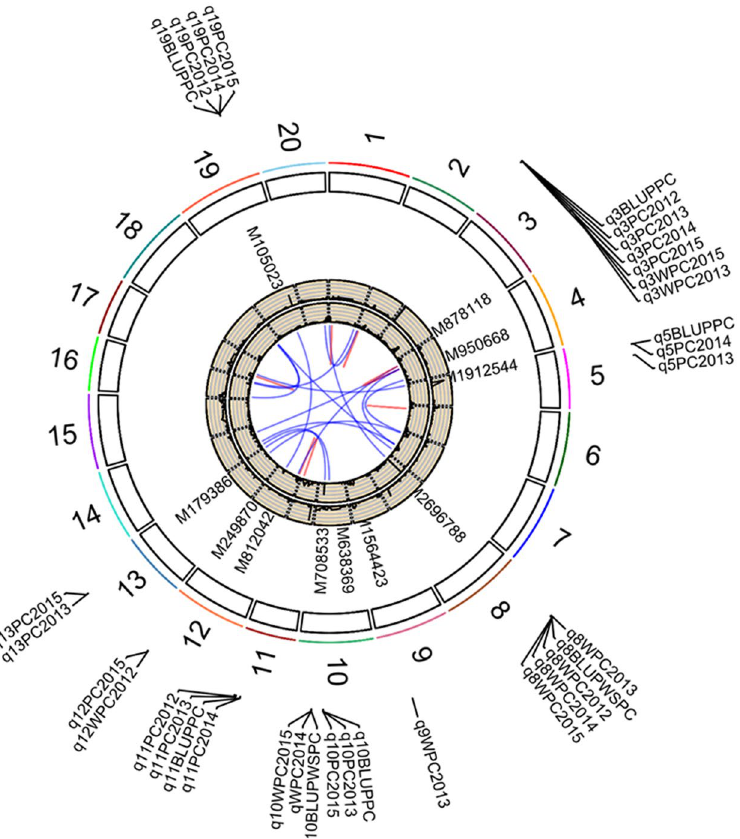
Figure 5. QTLs for soybean protein content (PC) and water-soluble protein content (WSPC) on soybean chromosomes by linkage mapping in RIL population. The lines link denotes epistatic associations between QTL and QTL. Blue line denotes two QTLs in different chromosomes, while red line denotes two QTLs in the same chromosome. The outside/inside wheat-colored circle indicates the LOD/PVE value curve for investigated traits across environments. The outermost circle indicates the 20 soybean chromosomes, QTLs for PC/WSPC, the position and linked markers of these QTLs on the